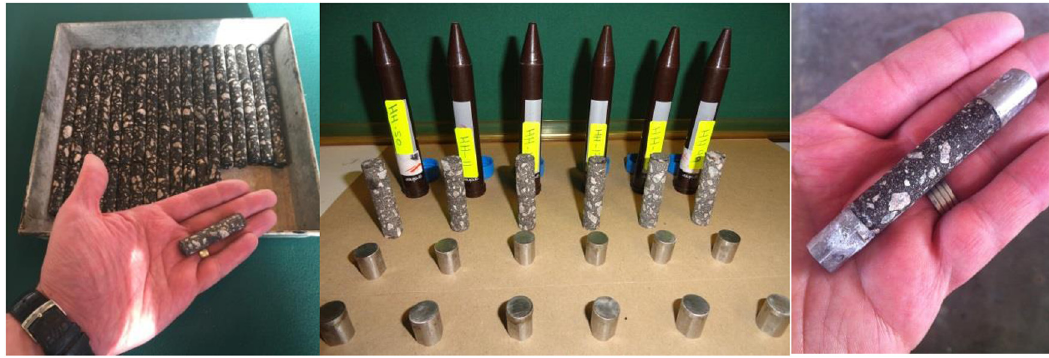
Figure 2: Cylindrical DSR specimens ready for testing.